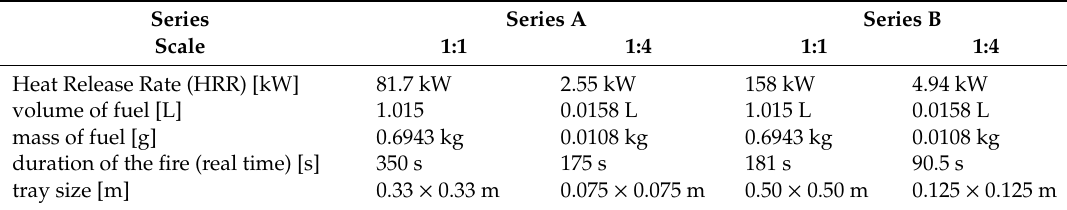
Table 1. Overview of the experiments.